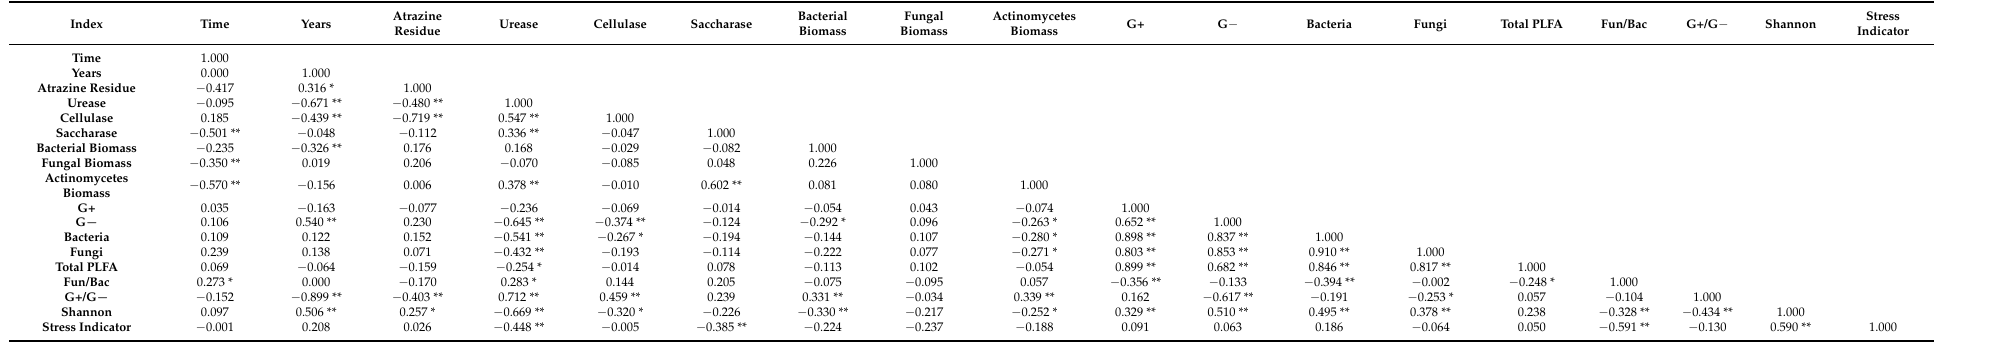
Table 2. Pearson correlation coefficient between soil PLFA index and environmental